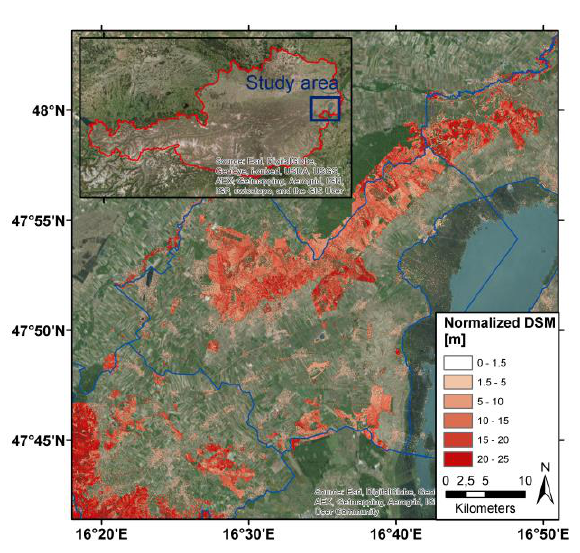
Figure 1: Overview of the study area. The ArcGIS Online basemap orthophoto is overlaid with the normalized DSM, derived from ALS data. The cells where the normalized DSM is smaller than 1.5 m are plotted as